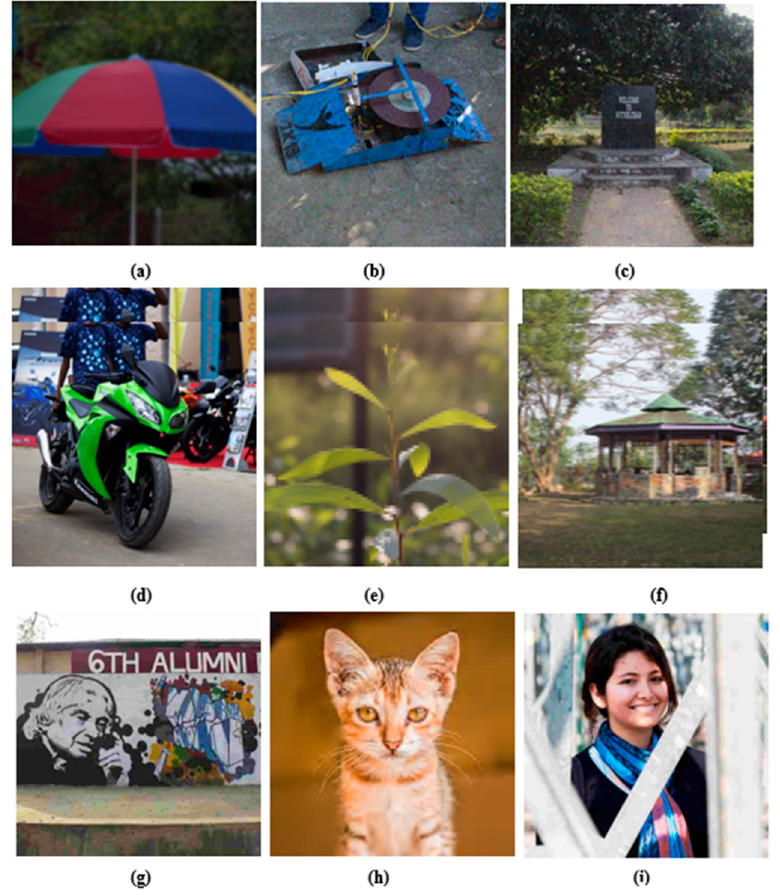
Figure 3. Distorted images sample ( a ) Gaussian blur, ( b ) Gaussian noise (chromatic), ( c ) uniform noise (chromatic), ( d ) contrast change (without brightness change), ( e ) pixelate mosaic, ( f ) motion blur, ( g ) JPEG, ( h ) JPEG2000, ( i ) JPEG-XT.